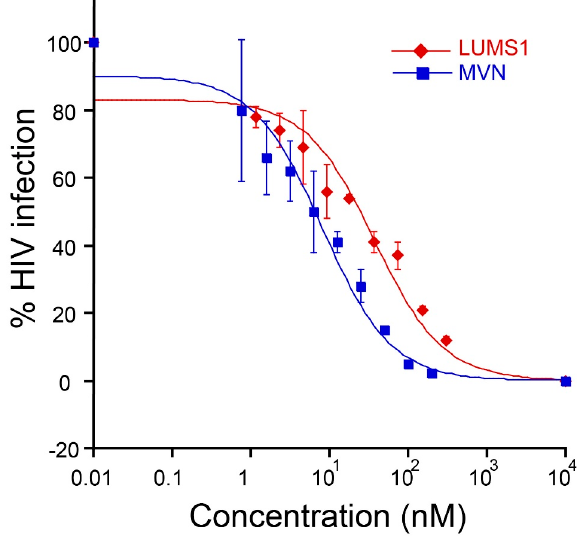
Figure 3. Human immunodeficiency virus (HIV-1) entry inhibition by LUMS1: dose-response curve showing inhibition of pseudo-typed virus, HIV-1 strain HXB2, by LUMS1 and MVN. The proteins at varying concentration was mixed with the virus at 37 °C followed by the addition of TZM-bl. After 48 h, cells were lysed, and percent infection was measured through luciferase activity. The assay was performed in triplicates.